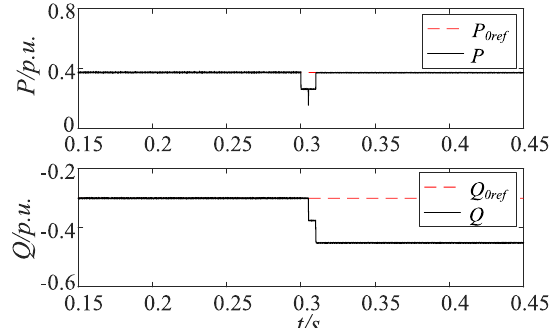
Fig. 14 Power waveform when the voltage drops in the rectified